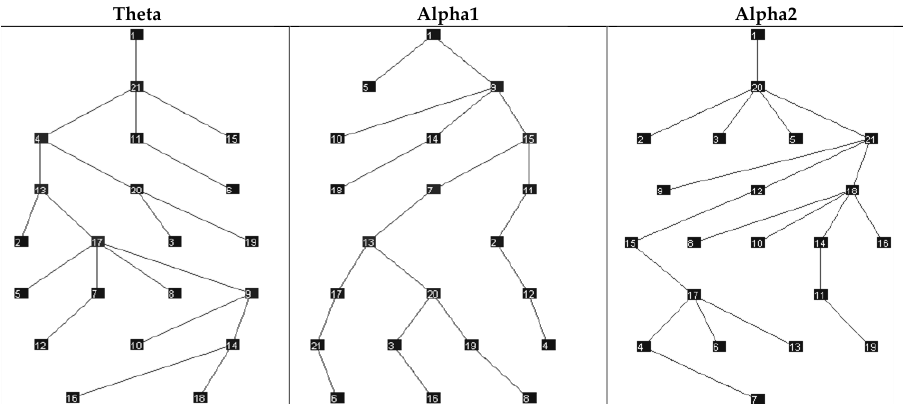
Figure 1. Average network maps for all patients for the theta, alpha1, and alpha2 frequency bands. The maps demonstrate the presence of correlations between pairs of channels, with threshold of 0.1 (PLI value) or correlations above that threshold.